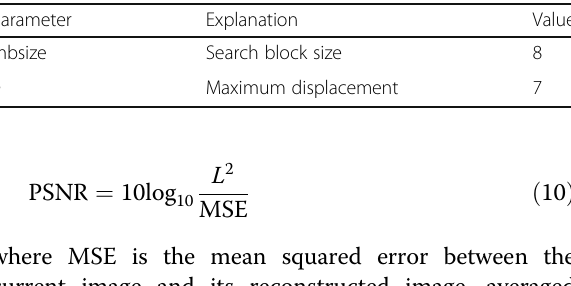
Table 1 Parameters of block-matching algorithm